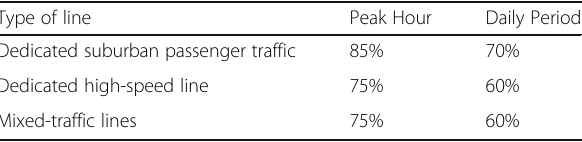
Table 1 Proposed occupancy time rate values Type of line Peak Hour Daily